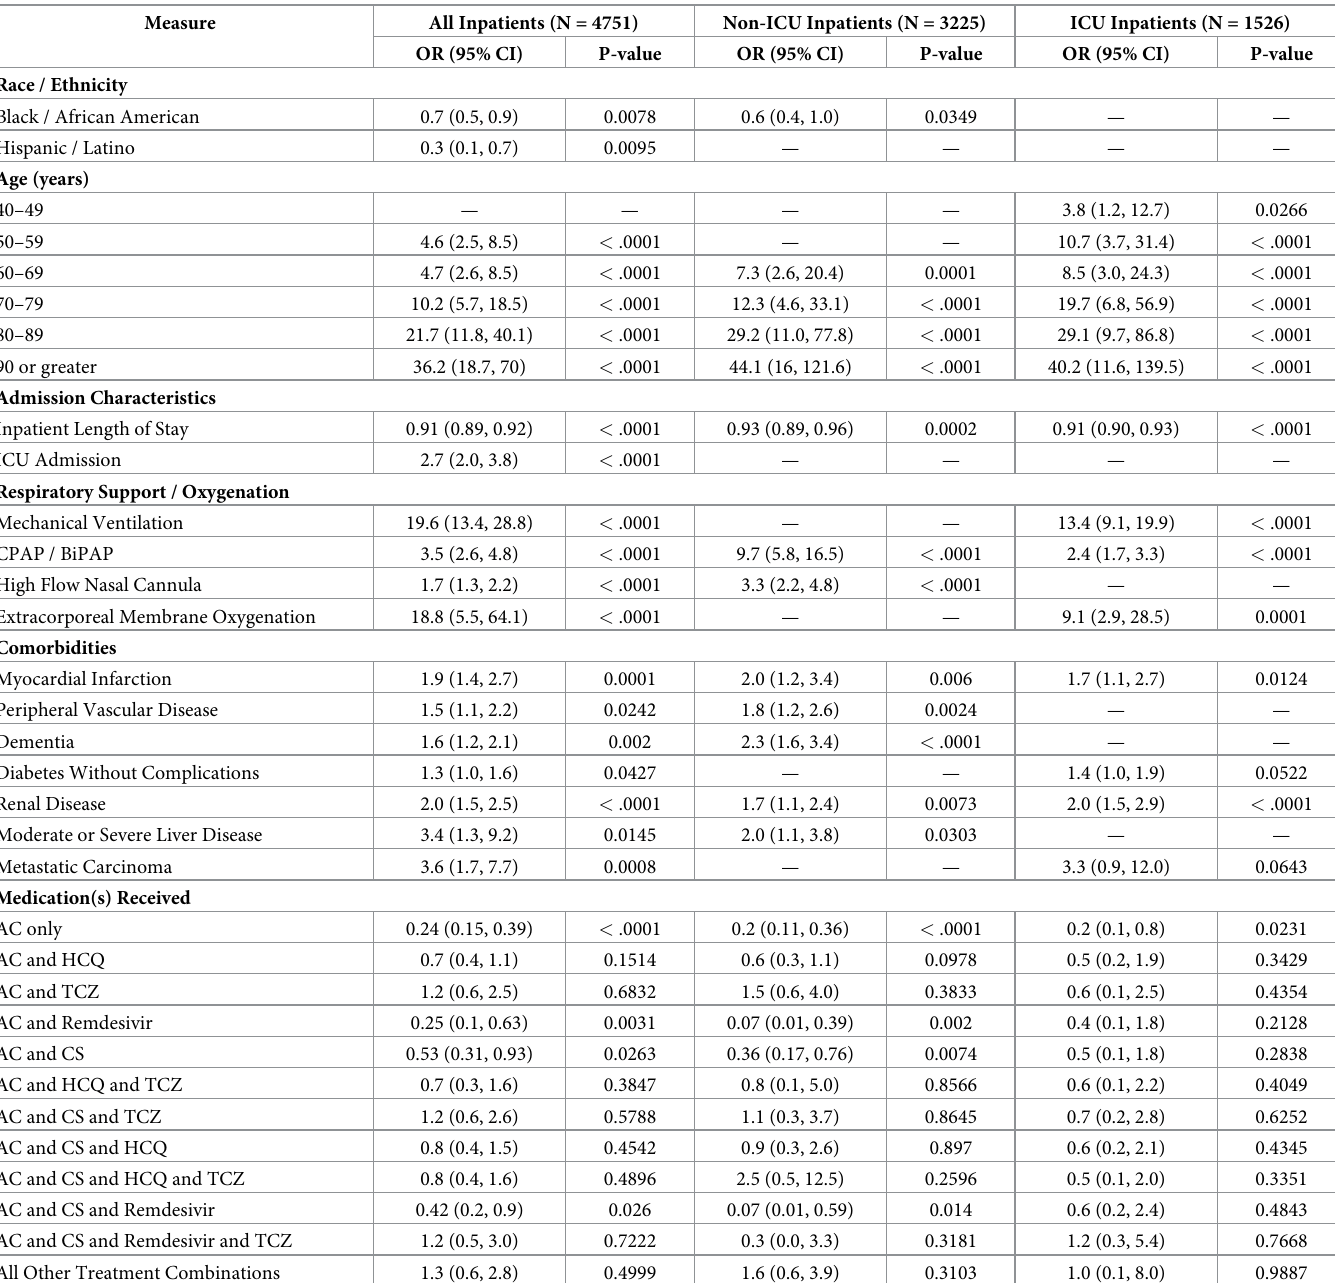
Table 3. Multivariable analysis of factors predicting mortality in COVID-19